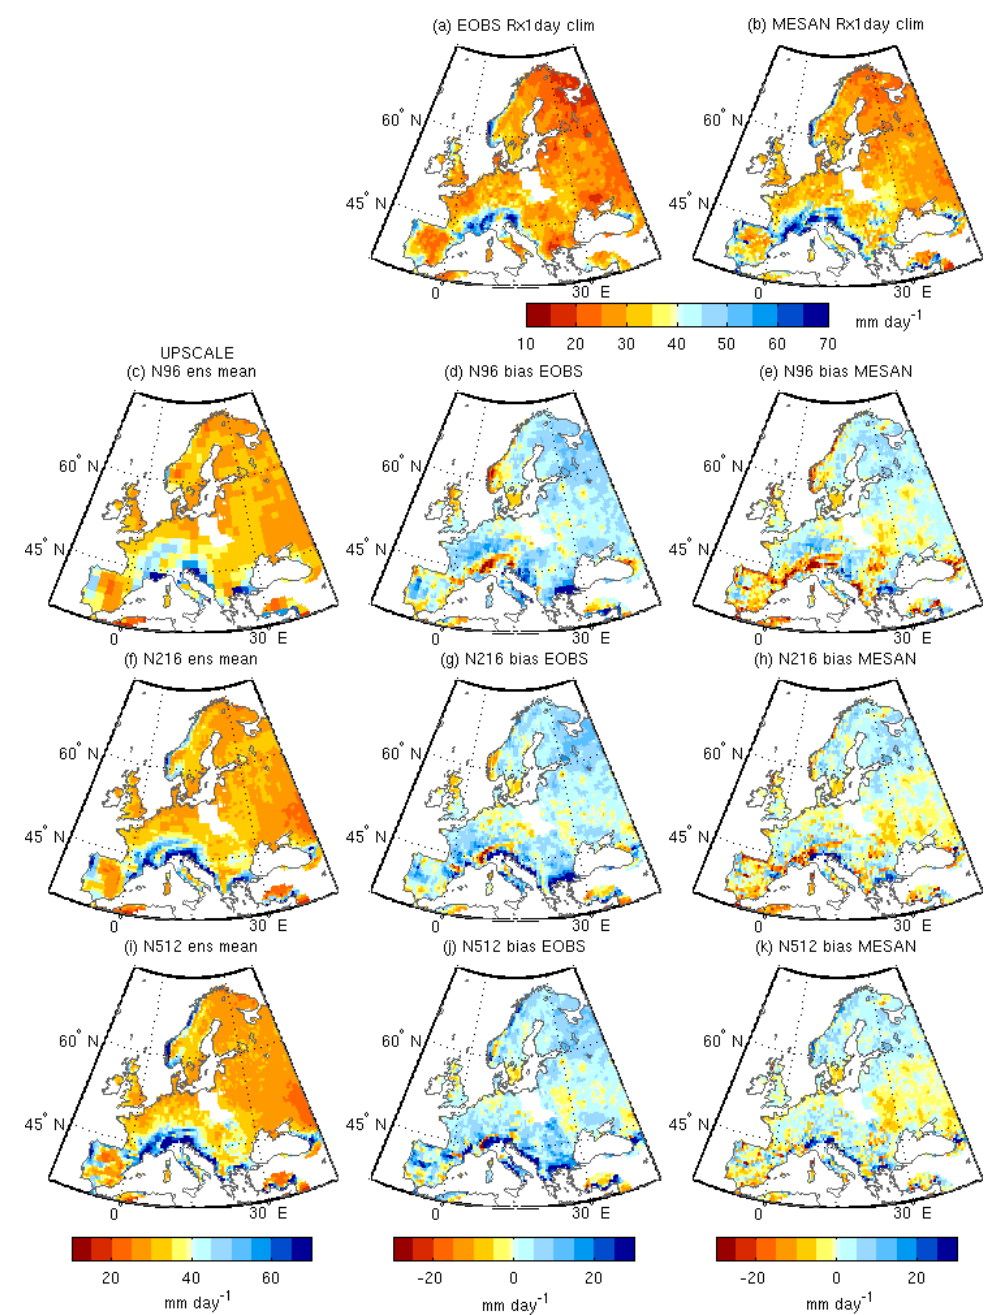
Figure 7. Climatological mean of Rx1day for the ensemble means of three resolutions of UPSCALE (left) simulations for the period 1989– 2010 and their biases with respect to E-OBS (middle) and the MESAN reanalysis (right). (a) E-OBS, (b) MESAN, (c–e) N96, (f–h) N216, and (i–k) N512. Units: